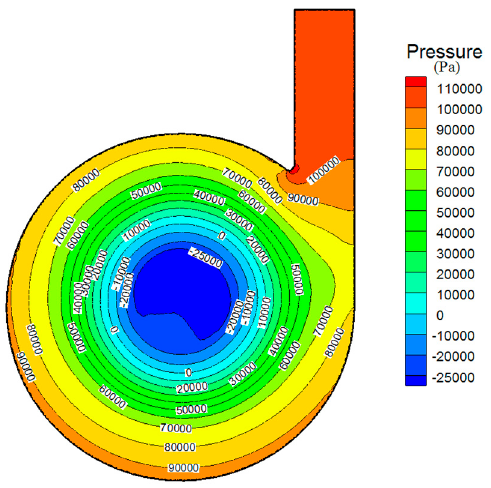
Figure 7. Static pressure distribution for the axial cross-section Z = 12.5 mm.